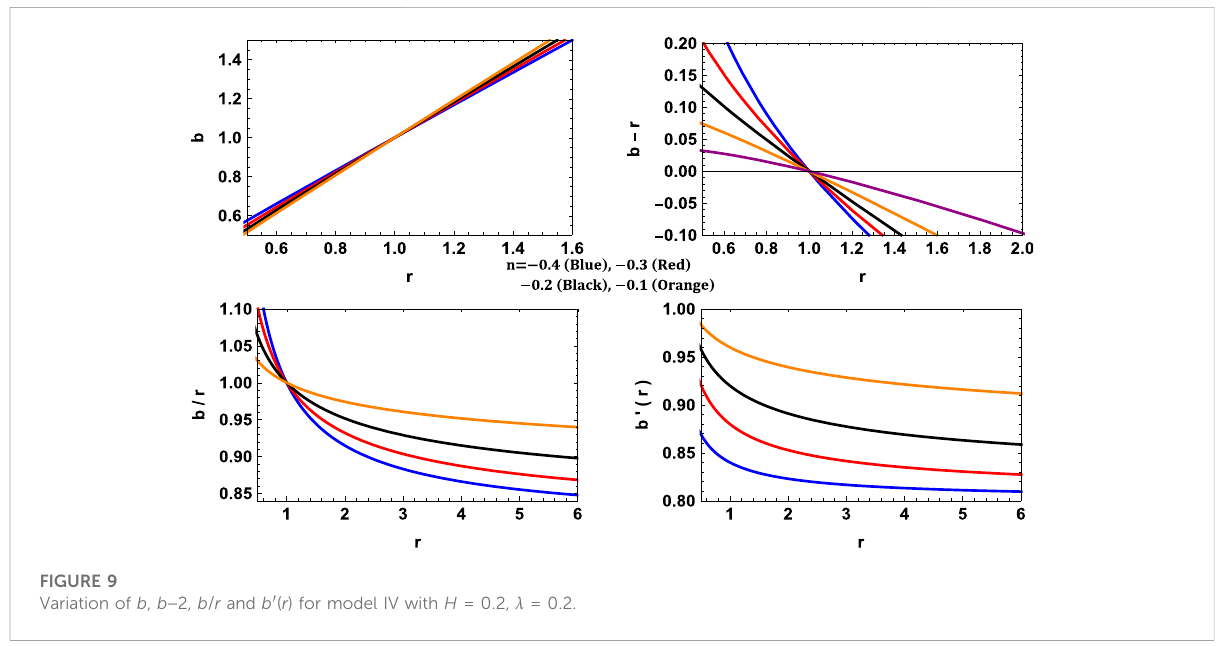
FIGURE 9 Variation of b , b − 2, b / r and b ′ ( r ) for model IV with H = 0.2, λ = 0.2.